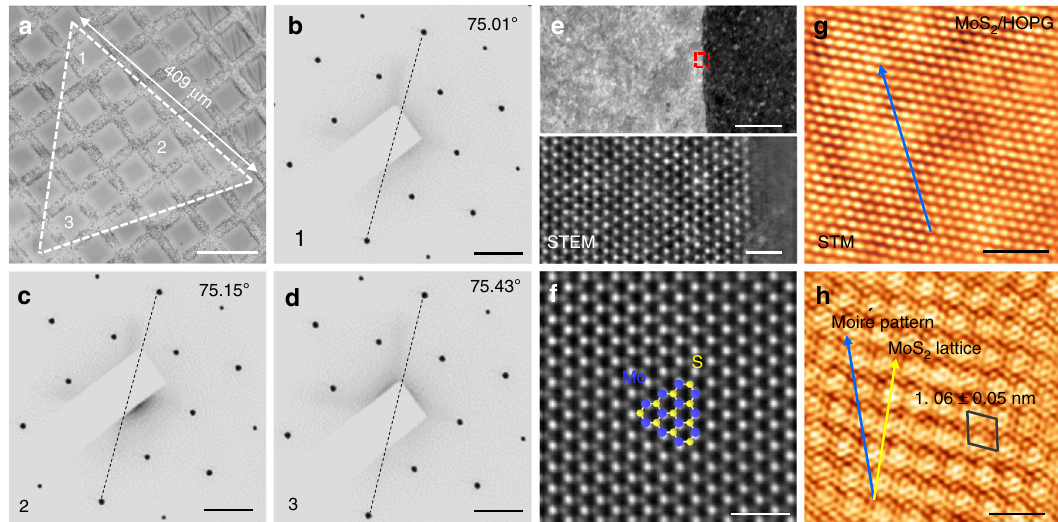
Fig. 4 Atomic structure of transferred monolayer MoS 2 . a OM image of a transferred MoS 2 domain on a carbon TEM grid, scale bars: 100 µ m. b – d SAED patterns from the regions numbered 1 – 3 in a . The dashed lines indicate the rotation angles (75.01°, 75.15°, and 75.43°) with respect to the horizontal line (scale bar: 3 nm − 1 ). e STEM (upper) image of the MoS 2 domain edge and the enlarged view (lower) of the marked rectangular region. Scale bars: 20 and 1 nm, respectively. f Atomically resolved image representing the defect-free hexagonal structure of MoS 2 . The bright spots are Mo atoms and the gray spots correspond to two-stacked S atoms. Scale bars: 1 nm. g Representative Moiré-scale STM image of MoS 2 transferred on HOPG ( V T = − 0.21 V, I T = 5.19 nA, scale bar: 5 nm) and h corresponding atomic-resolution STM image ( V T = − 0.33 V, I T = 5.19 nA, scale bar: 2 nm). The arrows indicate the directions of the MoS 2 lattice (yellow) and the Moiré pattern (blue). The unit cell for the Moiré pattern is outlined with a rhombus (period of 1.06 ± 0.05